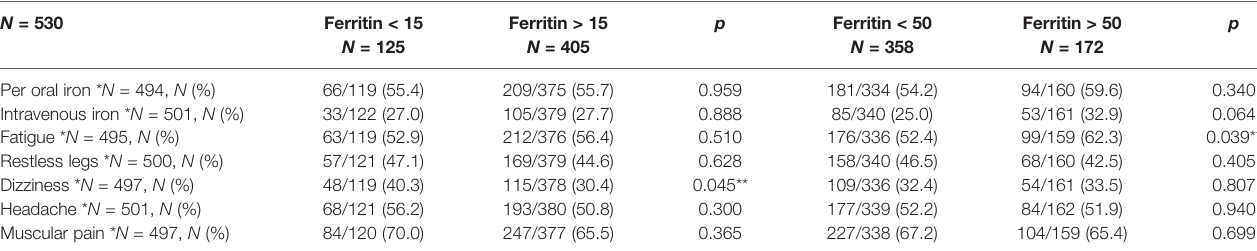
TABLE 3 | Iron supplements and symptoms possibly related to low iron stores one decade after RYGB, at two different threshold values of ferritin. N = 530 Ferritin < 15 N = 125 Per oral iron * N = 494, N